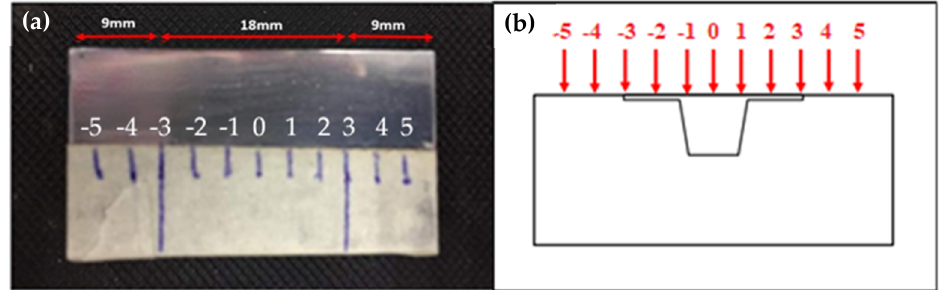
Figure 5. ( a ) Photograph of sample top view and ( b ) schematic diagram of sample sectional view with location number of indentations taken for the microhardness test.